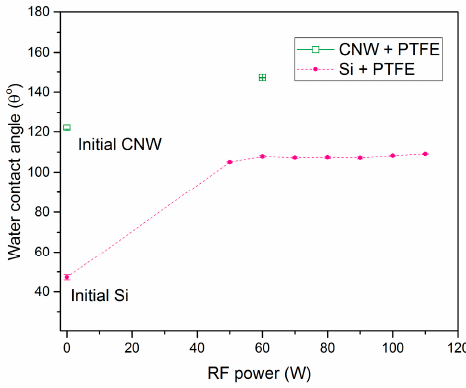
Figure 13. The dependence of the water contact angle on applied RF power for the PTFE-like